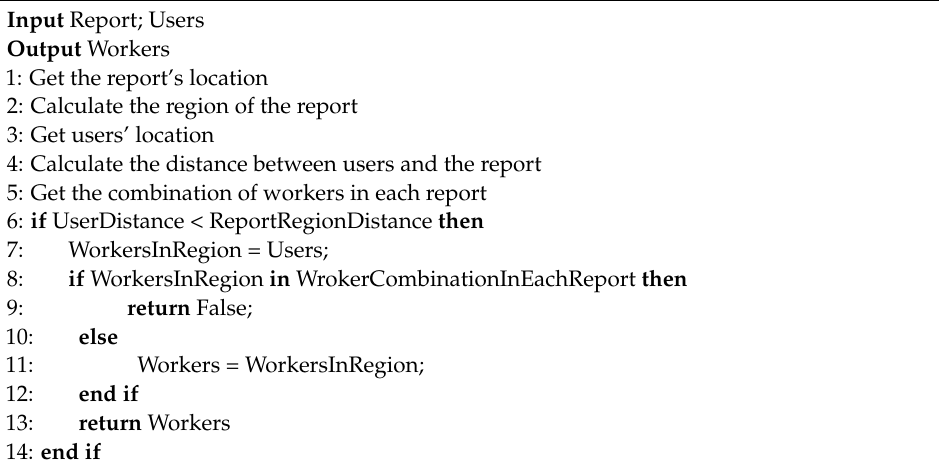
Algorithm 1. Task Assignment Algorithm.